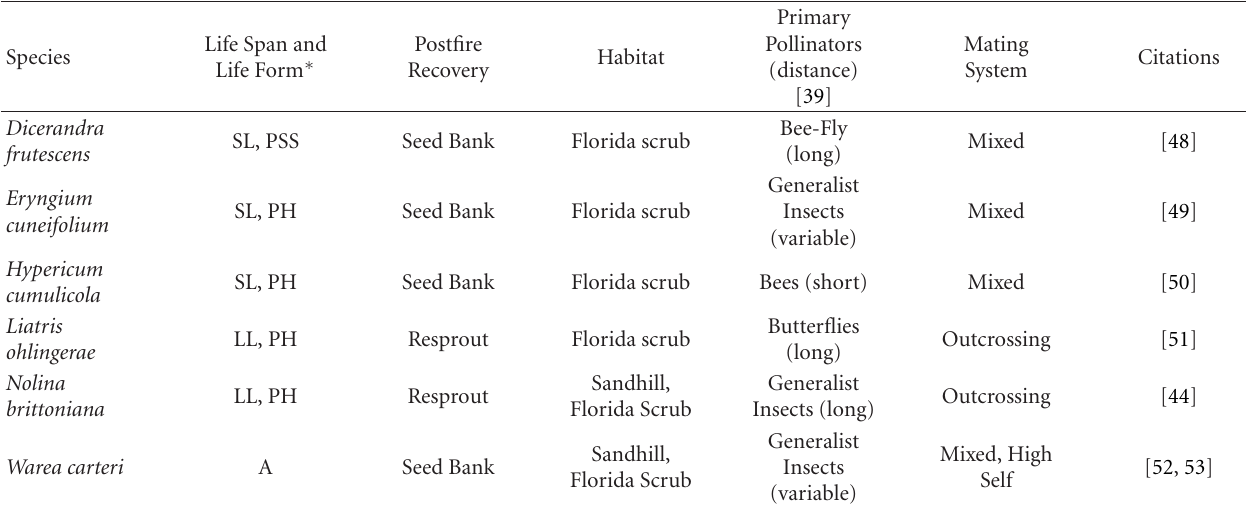
Table 1: Biological information on our study species.